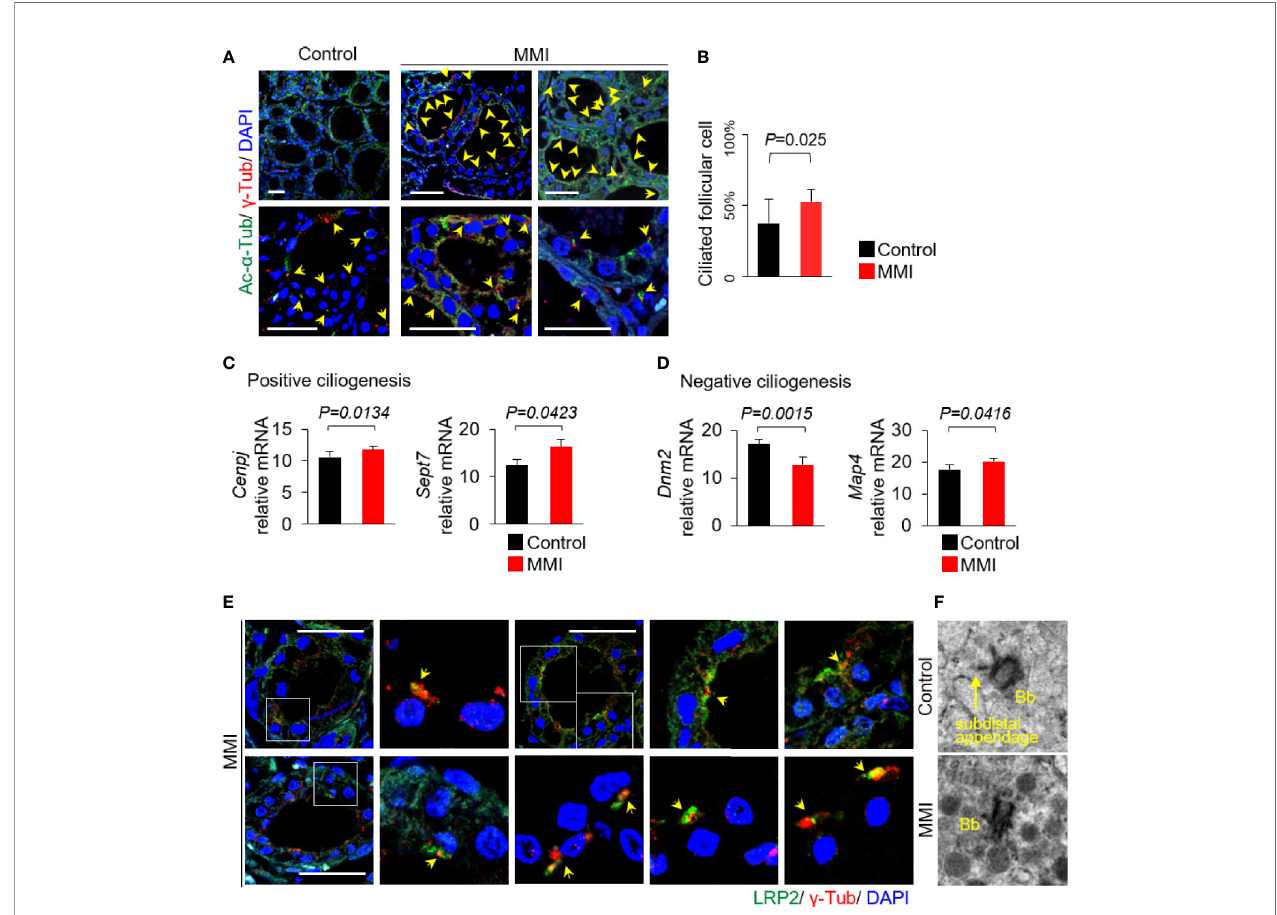
FIGURE 3 | Increased ciliogenesis in thyroid follicles of MMI-treated mice. (A) Primary cilia were con fi rmed by immuno fl uorescence staining with anti-acetylated a -tubulin (Ac- a -Tub, green) and anti- g -tubulin ( g -Tub, red). Primary cilia are indicated by arrows. Scale bar, 20 m m. (B) Frequency of thyroid follicles containing primary cilia was 37.80 ± 16.75% in the control group and 52.65 ± 9.57% in MMI-treated mice. Ciliogenesis in the thyroid was higher in MMI-treated mice than in control mice ( P = 0.025). Arrow indicates primary cilia. (C) Two genes involved in positive ciliogenesis, Cenpj ( P = 0.0134) and Sept7 ( P = 0.0423), were expressed at signi fi cantly higher levels in the thyroid of MMI-treated mice than in the control group. (D) A gene involved in negative regulation of primary cilia assembly, Dnm2 , was expressed at signi fi cantly lower levels in the thyroid of MMI-treated mice than in the control group ( P = 0.0015). By contrast, Map4 was upregulated in the thyroid of MMI-treated mice ( P = 0.0416). (E) In thyroid follicular cells of MMI-treated mice, LRP2/megalin (green) localized with g -tubulin (red, basal body marker), indicating the presence of LRP2/megalin in the basal body of the primary cilium (arrow). Scale bar, 20 m m. (F) TEM revealed highly abundant endocytic vesicles and lysosomes primarily located near the basal body (Bb) in thyroid follicles of MMI-treated